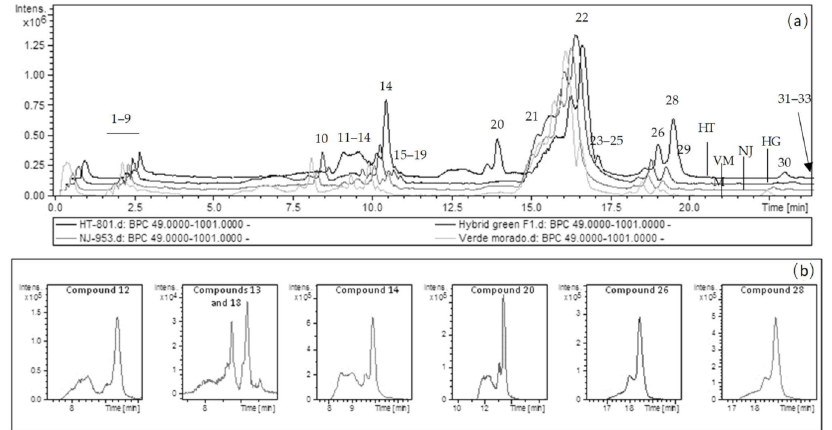
Figure 1. ( a ) HPLC-ESI-TOF/MS base peak chromatogram (BPC) in negative ion polarity of the four varieties studied: HT–801 (HT), Hybrid green (HG), NJ–953 (NJ), and Verde-morado (VM). ( b ) Extracted ion chromatogram (EIC) of selected compounds in the representative variety HT–801 (HT). From left to right: compound 12 ( p -coumaroylquinic acid), compounds 13 and 18 (feruloylhex- osylhexose isomers 1 and 2), compound 14 (feruloylquinic acid), compound 20 (quercetin rhamnosyl rutinoside isomer 1), compound 26 (kaempferol-3- O -rutinoside [nicotiflorin]), and compound 28 (isorhamnetin-3- O -rutinoside [narcissin]). Peak number, retention time, m/z , molecular formula, and absorbance of each peak are provided in Table S1. Abbreviations: HT, HT-801; HG, hybrid green F1; NJ, NJ-953; VM, “verde